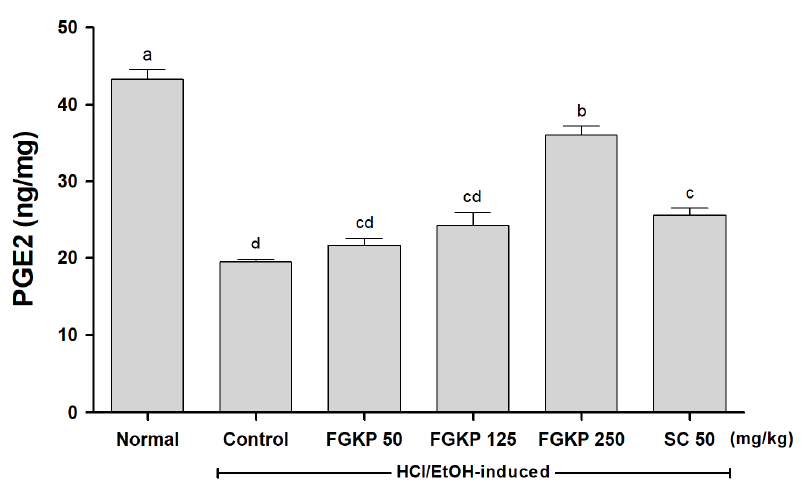
Figure 8. Effect of fermented gold kiwi (FGK) on PGE2 expression in the stomach tissues of HCl/EtOH-induced rats. Normal, rats treated with only DW; Control, rats treated with HCl/EtOH; SC 50, rats treated with HCl/EtOH and sucralfate; FGK, rats treated with HCl/EtOH and FGK (50, 125, and 250 mg/kg). Results are expressed as mean ± SEM (N = 8). a–d Different labels were significantly different at p < 0.05 between treatments, as determined by Tukey’s analysis.